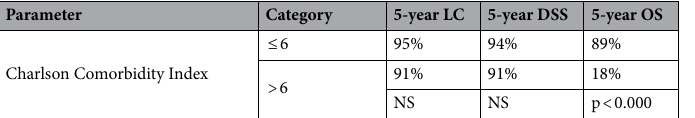
Table 1. The results of univariate analysis of correlations between selected clinical parameters in relation to 5-year local control (LC), disease-specific survival (DSS), and overall survival (OS). NS no significance.